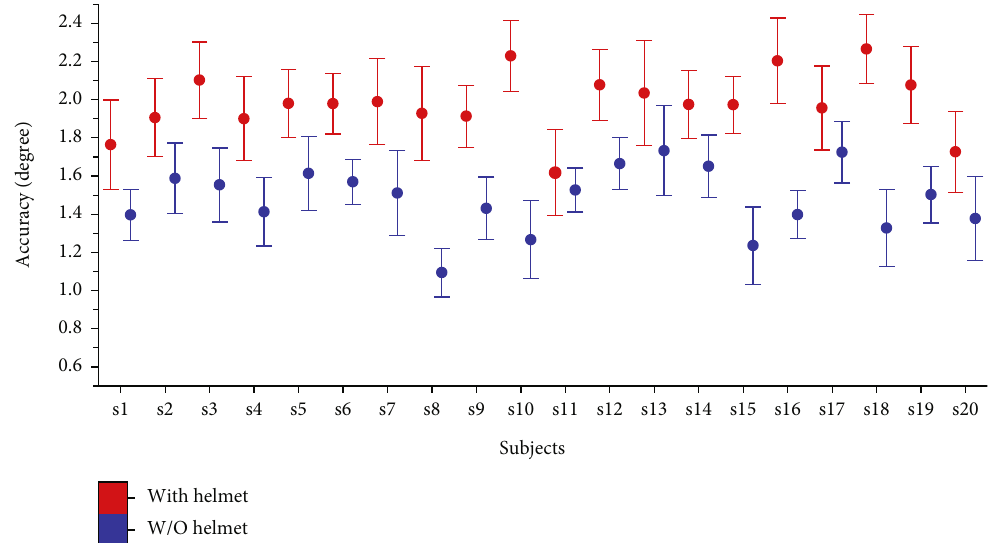
Figure 9: The average error from 20 subjects, without (blue) and with (red) helmets, looking at 9 markers at 60cm away from the screen.